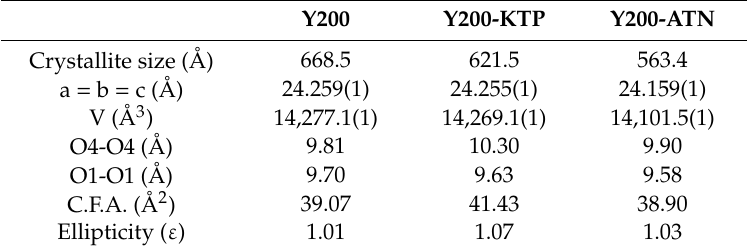
Table 2. Lattice Parameters for Y200 Before and After Pharmaceuticals